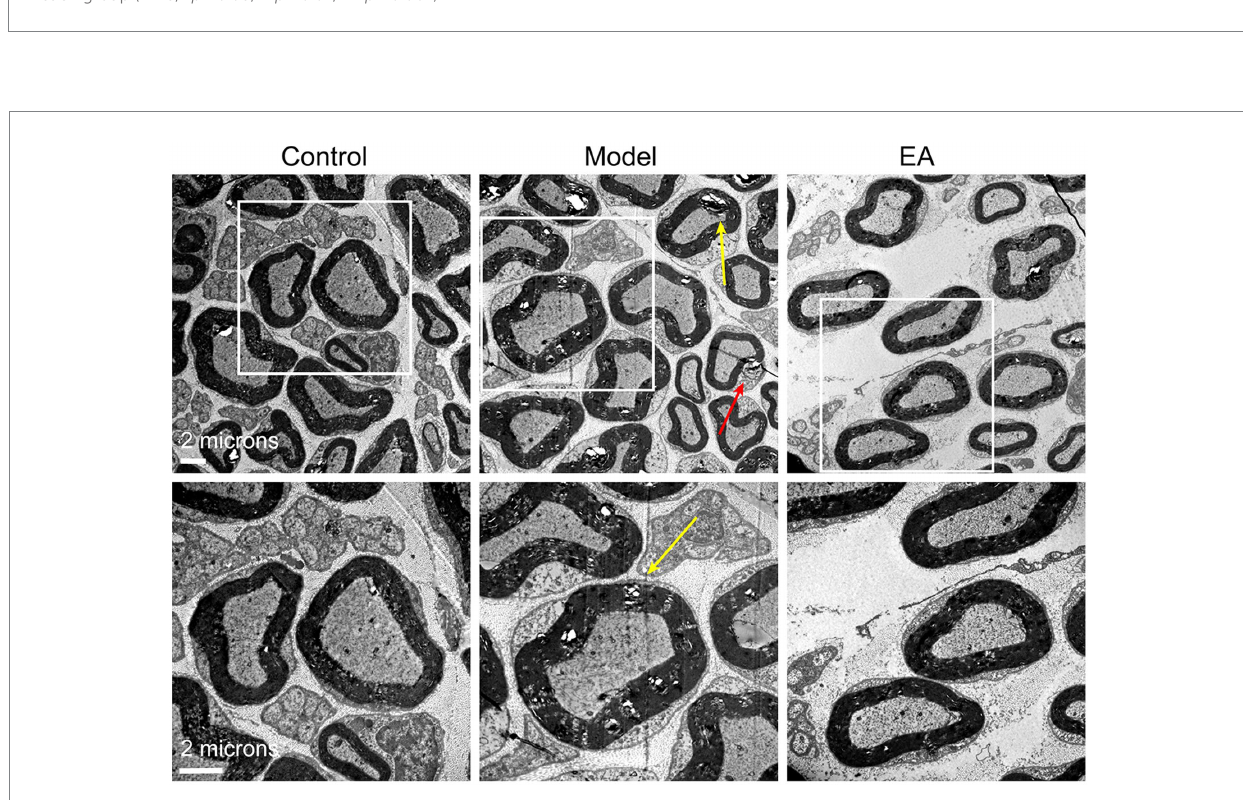
FIGURE 8 Electroacupuncture alleviated peripheral nerve damage and reduced firing rate in MIA-induced KOA rats. Representative sections of electron micrographs of axons found in the saphenous nerves were taken on day 14 after MIA in the control, model, and EA groups. The yellow arrow indicates nerve myelin damage; the red arrow indicates Schwann cell damage. The scale bar is 6 mm ( n = 3).